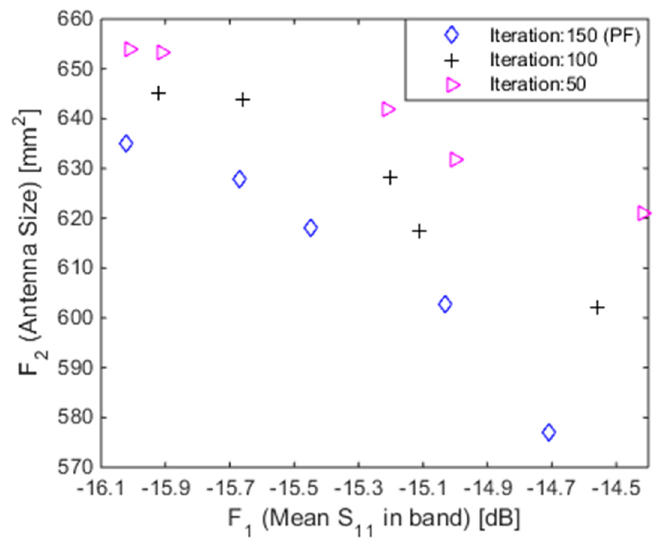
Figure 11. The obtained representations of the Pareto set during the optimization process for the planar